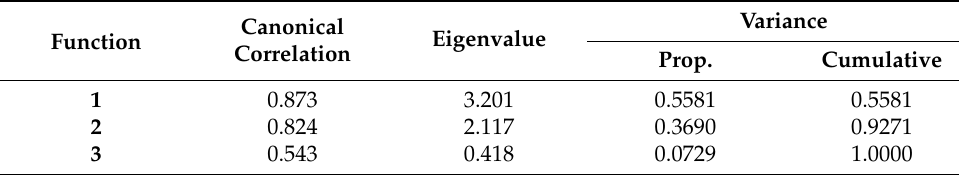
Table 2. Wilk’s Lambda results for discriminant